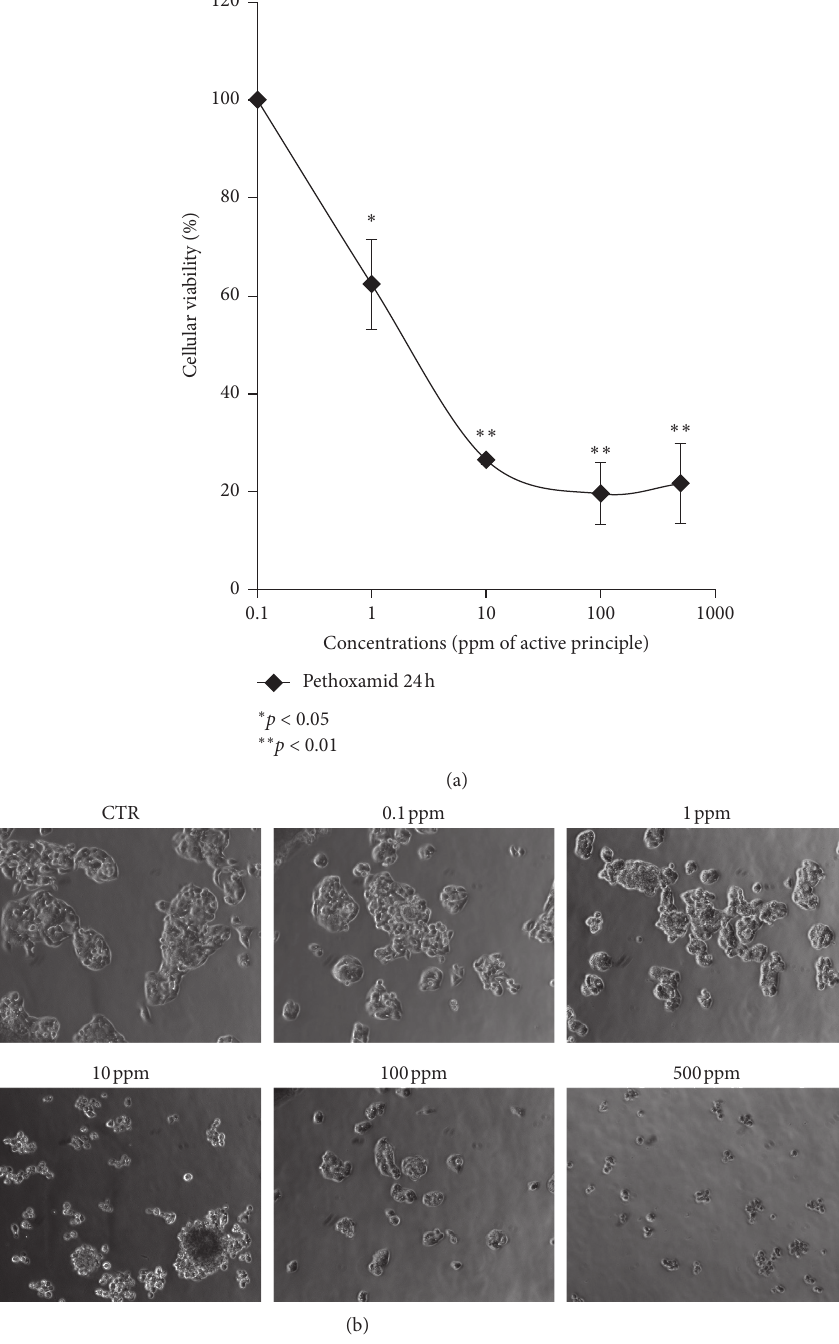
Figure 1: (a) Dose-dependent cytotoxicity of pethoxamid. Cell viability was significantly affected starting at 10ppm in 24h. Values are means ± SD from three separate experiments. (b) Representative HepG2 pictures panel in the presence of pethoxamid at different concentrations. ∗ P < 0 . 05 and ∗∗ P < 0 . 01 t -test analyses were performed to compare the significance of each treatment with respect to